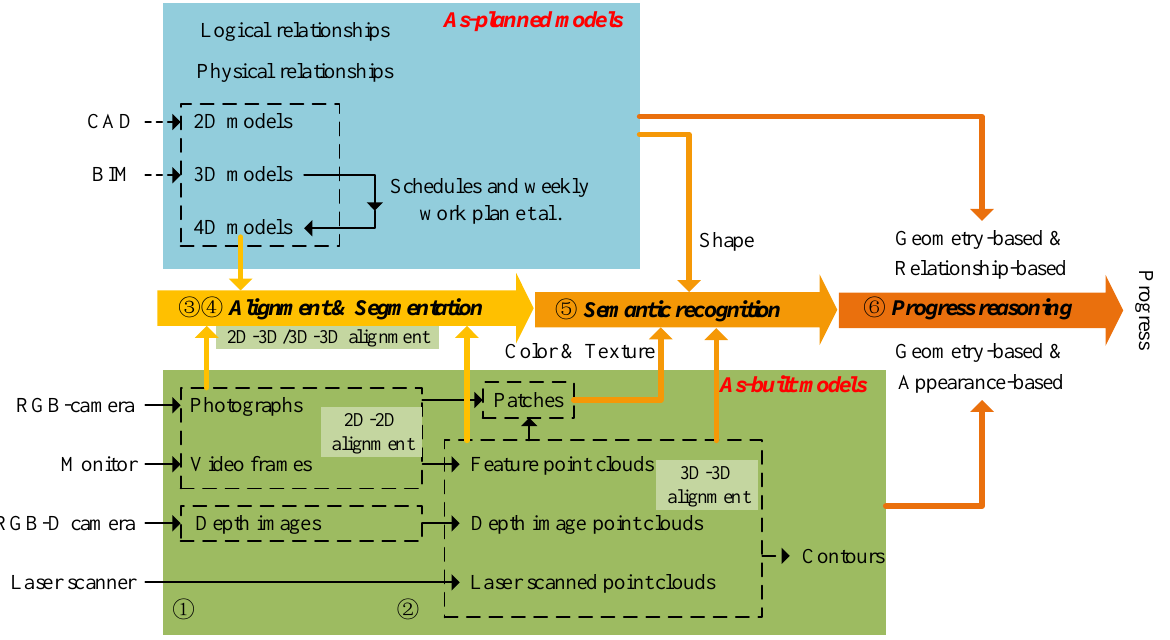
Figure 1. Research map for image-based 3D